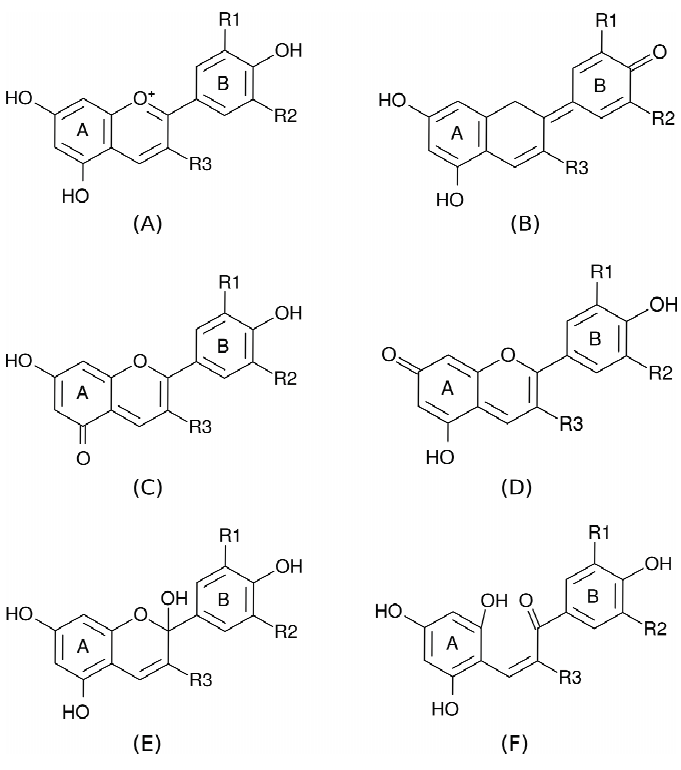
Figure 1. ( A ) Flavylium cation; ( B – D ) quinoidal bases; ( E ) carbinol pseudo base; ( F ) chalcone structure of